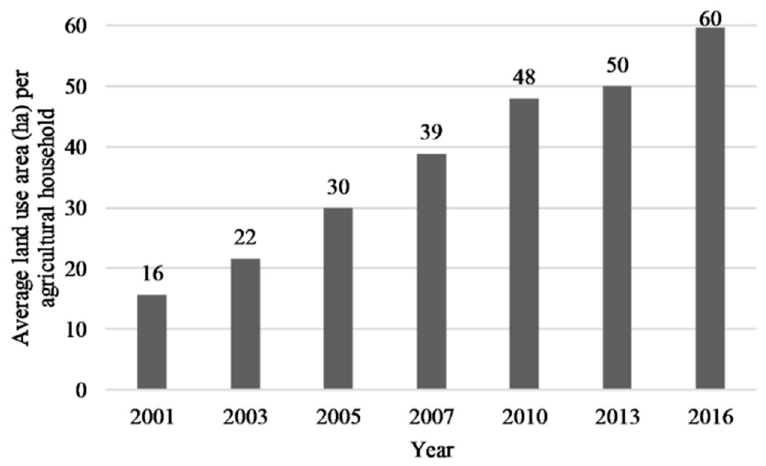
Figure 6. Average land use (ha) per agricultural household in Estonia between 2001 and 2016 (Statistics Estonia).